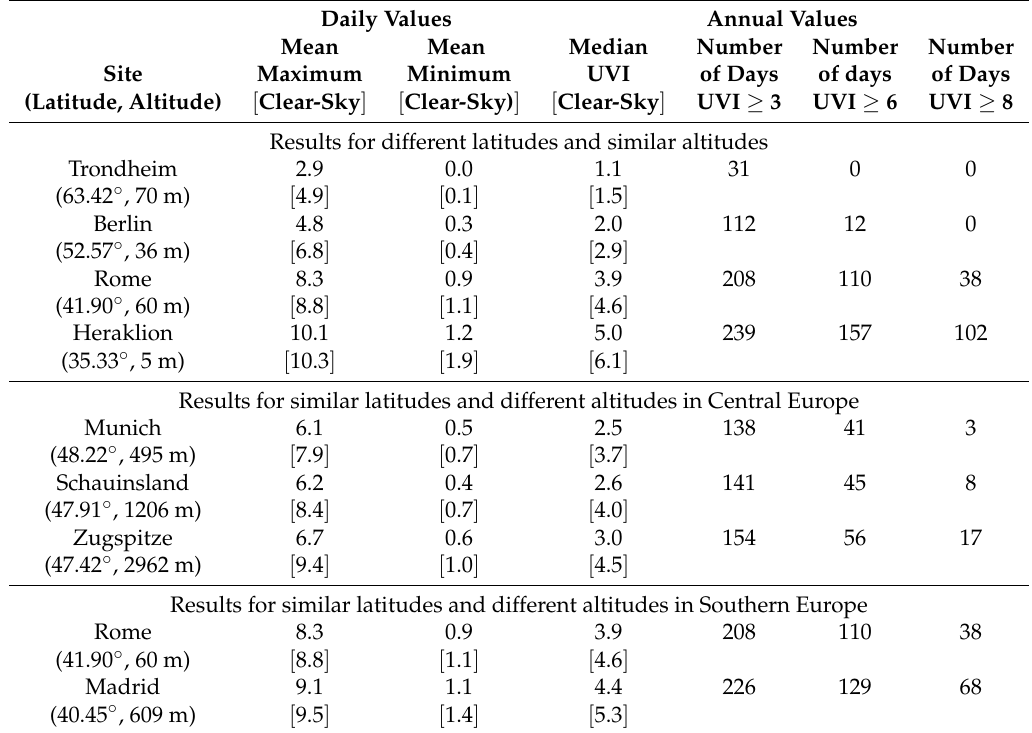
Table 3. Daily values of mean maximum, mean minimum and mean UVI and UVI clear − sky at local solar noon, as well as annual mean number of days with UVI ≥ 3, UVI ≥ 6 and UVI ≥ 8 at local solar noon for each location based on satellite